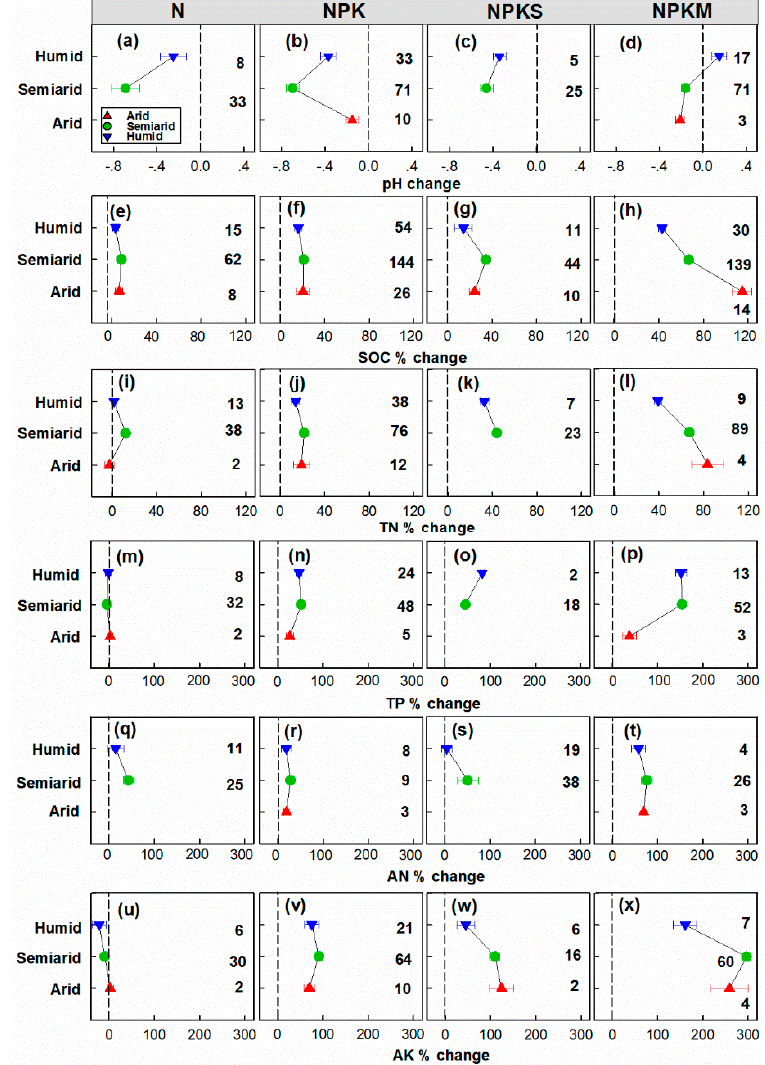
Figure 3. Effects of fertilizers (N, NPK (phosphorus, potassium and nitrogen), NPKS (NPK with straw returning), NPKM (NPK with manure)) on the soil chemical properties (pH ( a – d ), SOC ( e – h ), TN ( i – l ), TP ( m – p ), AN ( q – t ), AK ( u – x )) in regions with different HIs (humidity index) (HI = MAP/(MAT +